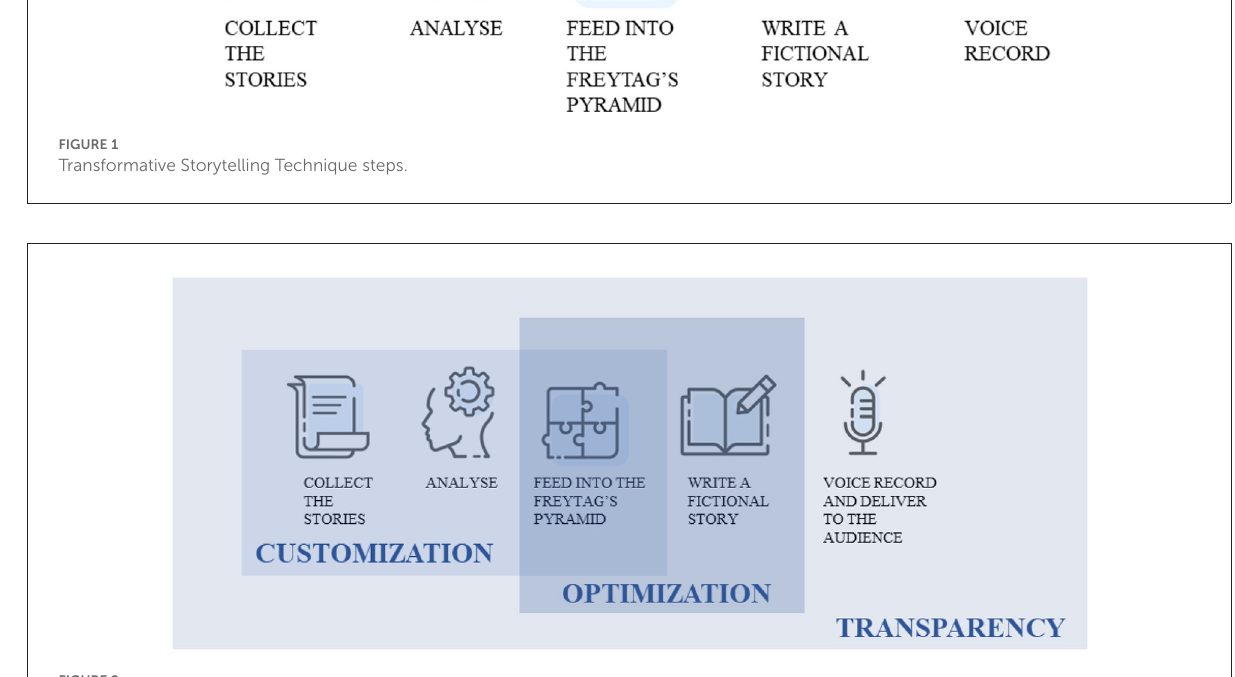
FIGURE2 Hierarchy in Transformative Storytelling